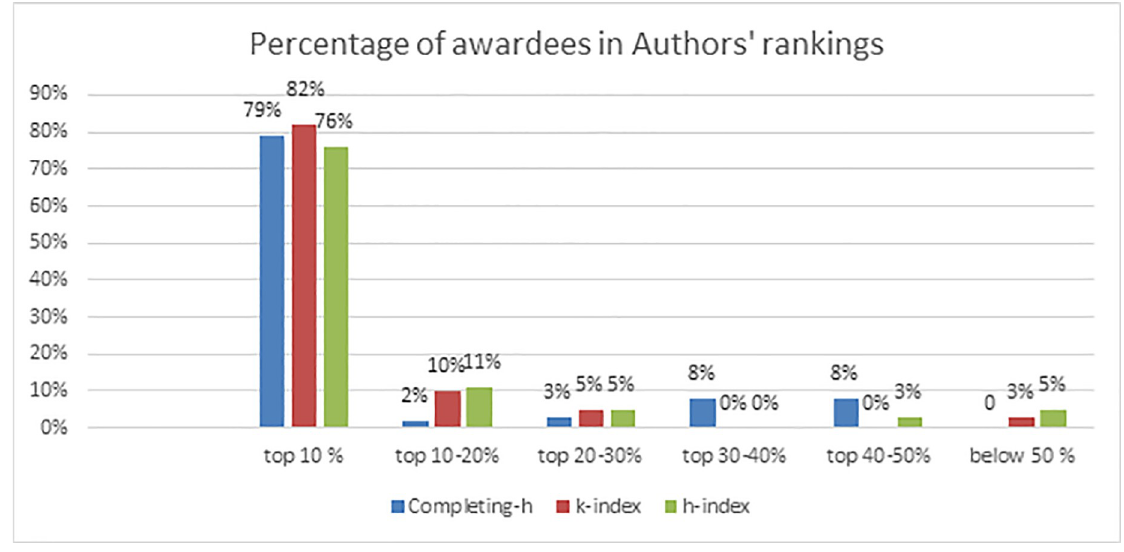
Fig 4. Occurrence of award winners in ranked lists.